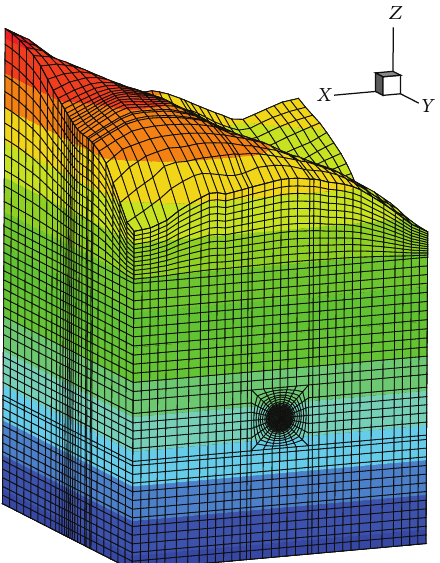
Figure 3: Complete finite element model of diversion tunnel.